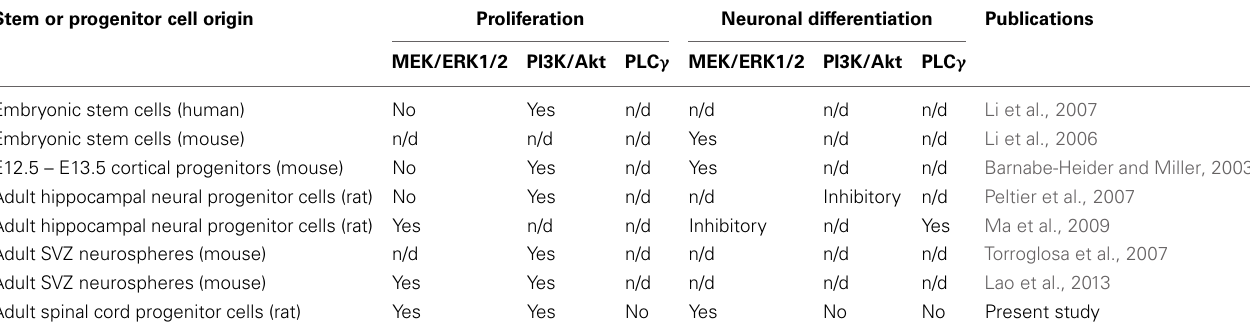
Table 1 | Contribution of ERK1/2, Akt, PLC γ to proliferation and neuronal differentiation of stem/progenitor cells. Stem or progenitor cell